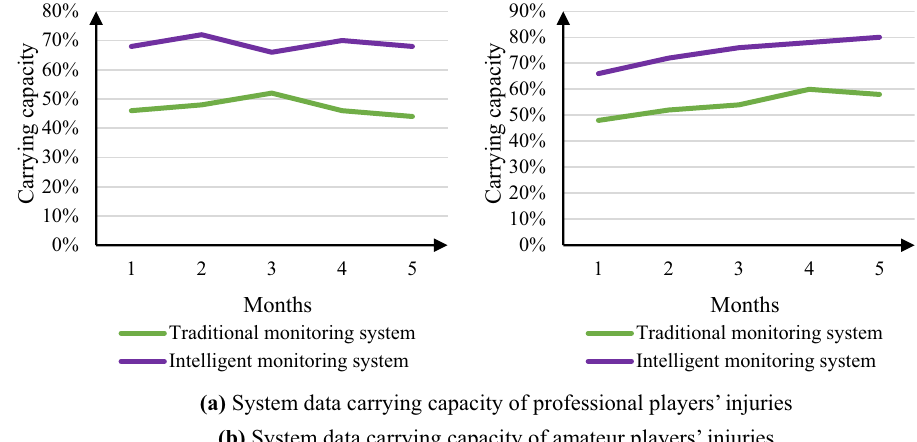
Fig. 7 Comparison results of system data carrying